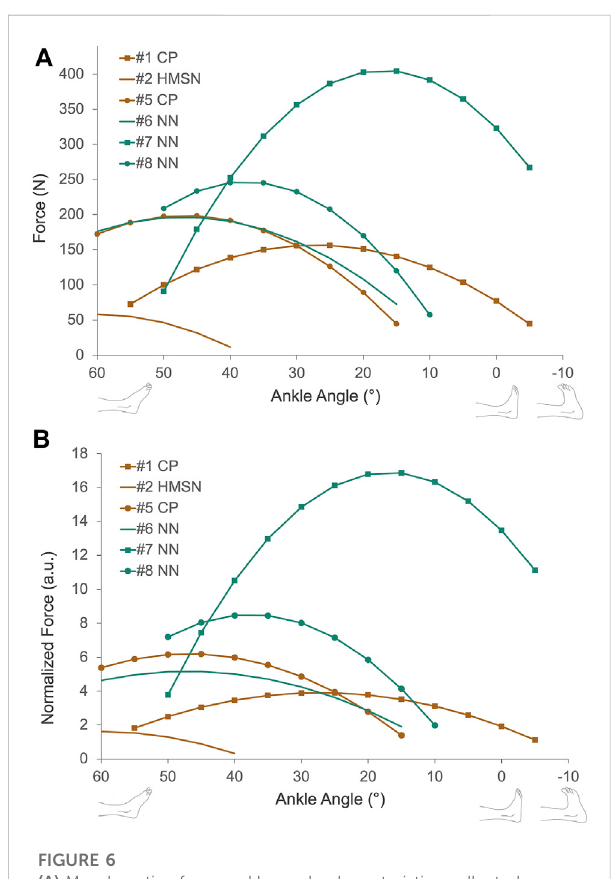
FIGURE 6 (A) Muscle active force-ankle-angle characteristics collected from six patients pre-ATL. Active force is calculated by subtracting passive force from the total measured force. (B) Normalized active force-ankle-angle characteristics pre-ATL. Active forces were normalized to the patient ’ s lower leg length. CP = Cerebral palsy, HMSN = hereditary motor and sensory neuropathy, NN = non- neurological